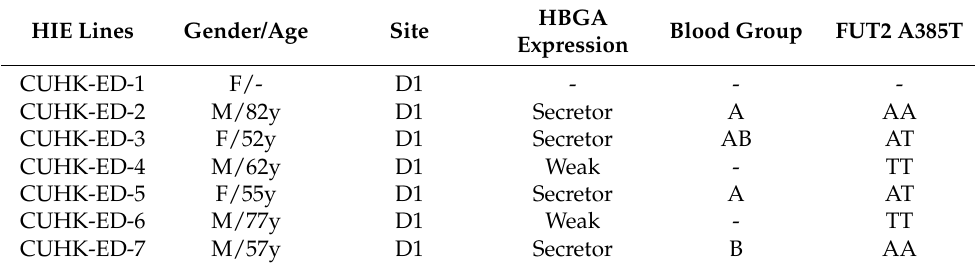
Table 1. Demographic characteristics of donors and secretor status of human intestinal enteroid (HIE) lines established in this